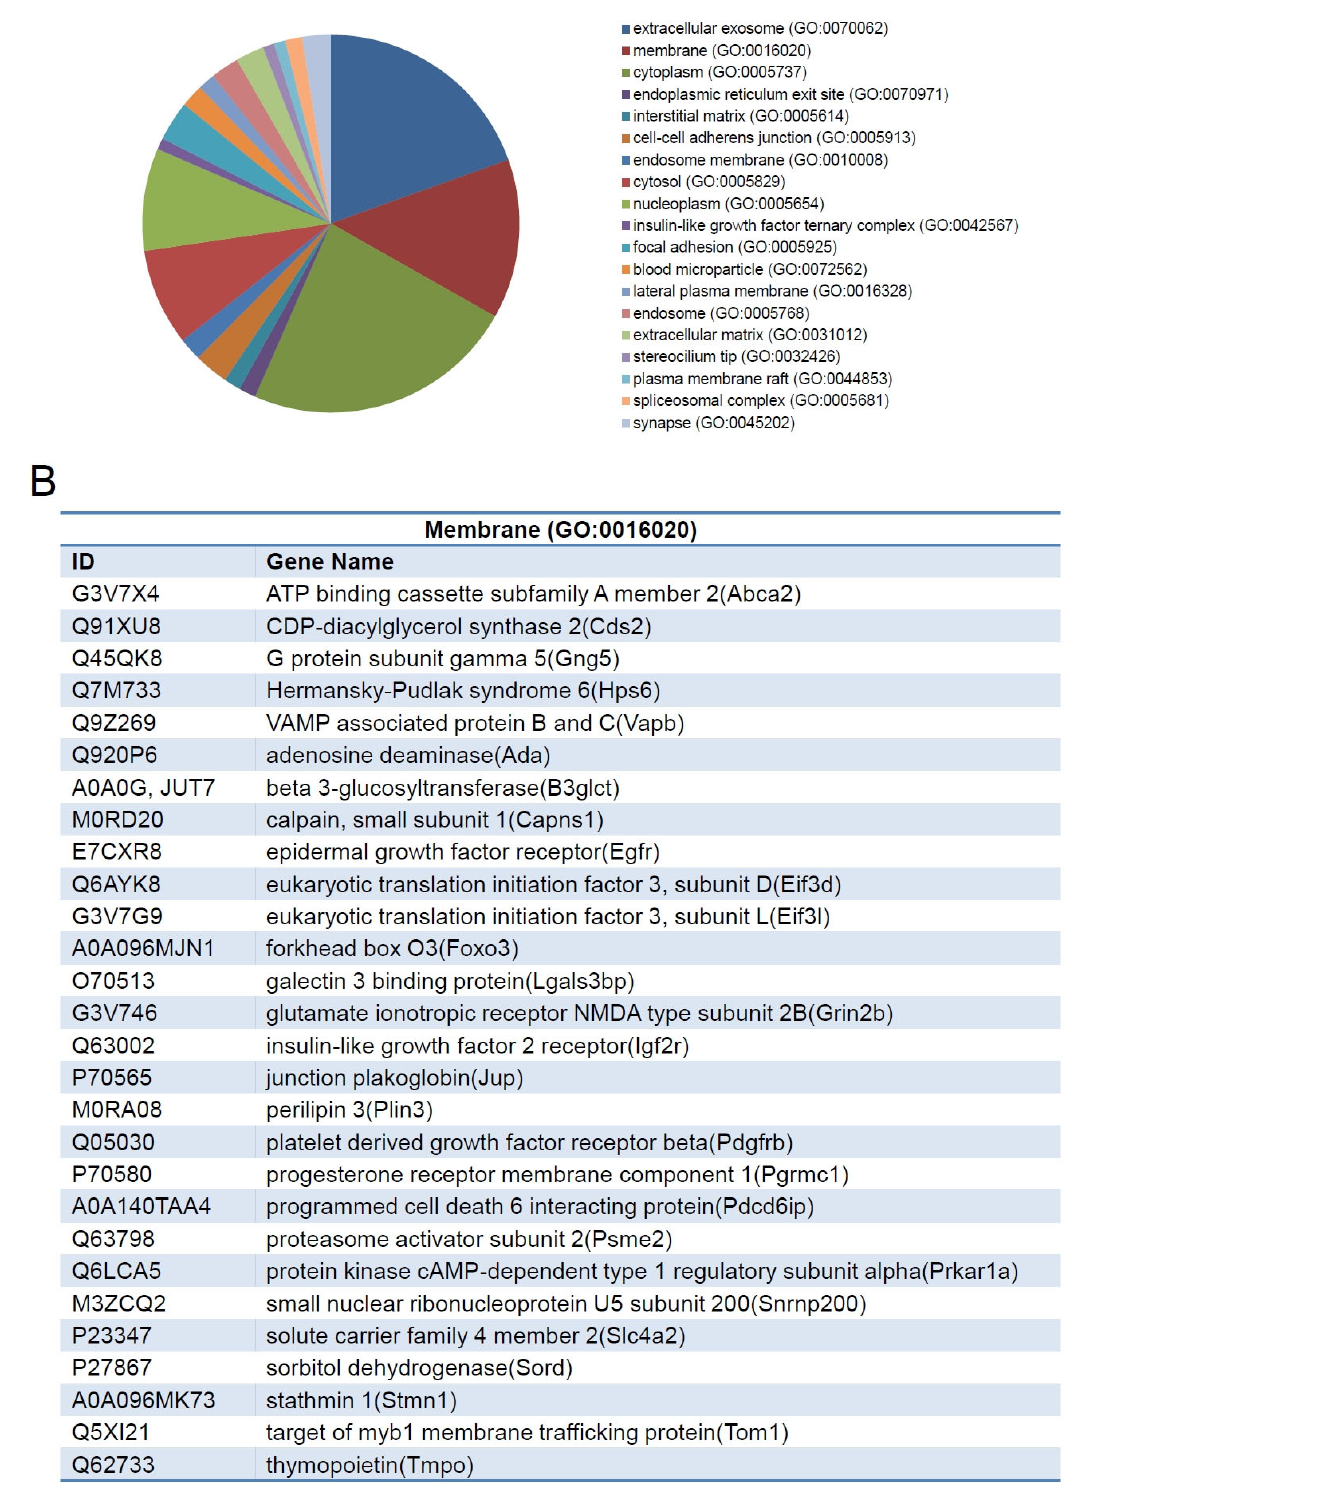
Figure 8. ( A ) Graph containing the GO enrichment analysis of exclusively identified proteins in PDL of control animals using DAVID software, which revealed that the proteins were related to the term “cellular component” (CC). ( B ) List of the proteins of the GO CC term